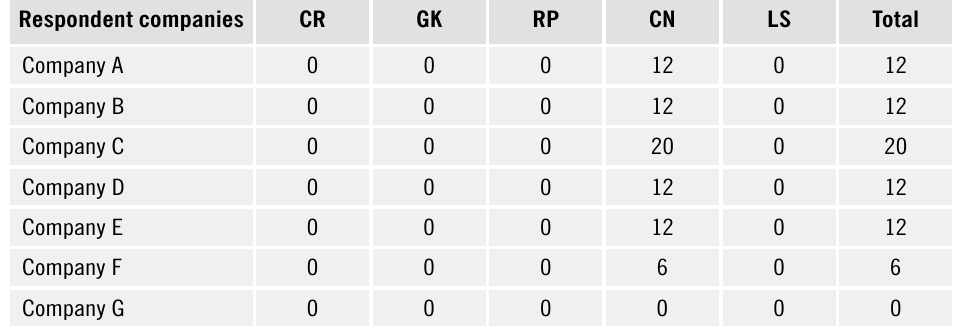
Table 15. Brokerage scores of the respondent companies with weighted